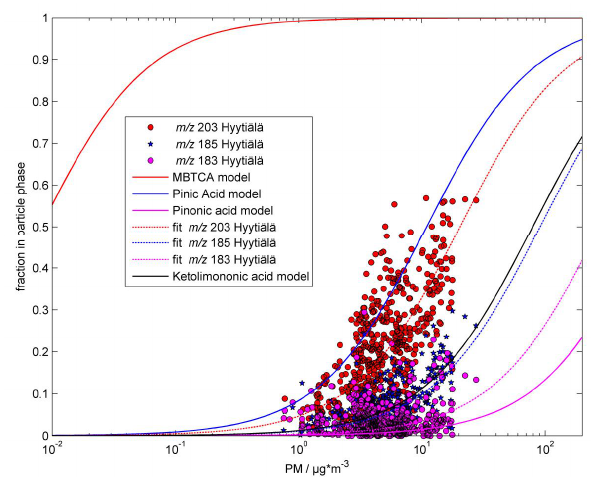
Fig. 8. Modelled (solid lines) gas-to-particle partitioning of three Figure 8. Modelled (solid lines) gas-to-particle partitioning of three distinct organic acids 2 distinct organic acids versus the measured (dashed lines) gas-to- versus the measured (dashed lines) gas-to-particle partitioning of the respective m/z ratios. 3 particle partitioning of the respective m/z ratios. The model as- The model assumes instantaneous partitioning (liquid particle phase). The measured data 4 sumes instantaneous partitioning (liquid particle phase). The mea- points are averaged on an hourly basis. For clarity, separated m/z data points are shown 5 sured data points are averaged on an hourly basis. For clarity, sepa- Fig. S3. 6 rated m/z data points are shown Fig.